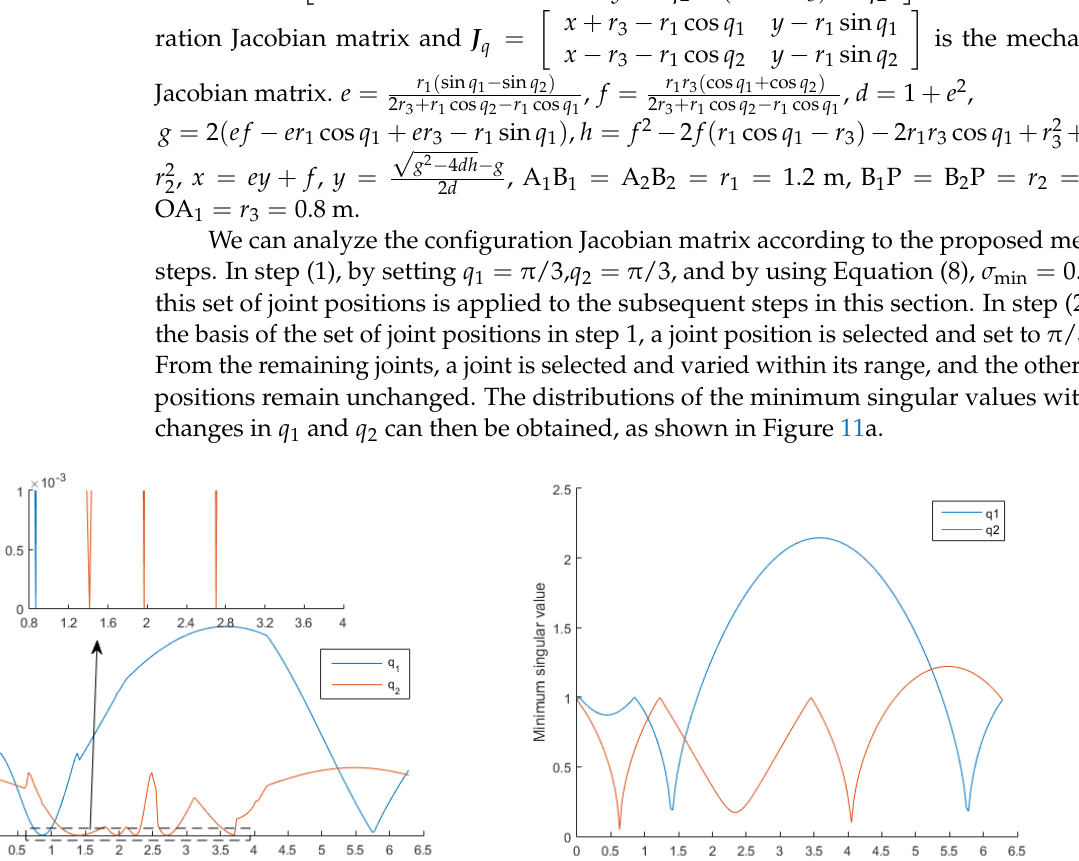
Figure 11. ( a ) The distributions of the minimum singular values of the configuration Jacobian matrix with the changes in q 1 and q 2 ; ( b ) the distributions of the minimum singular values of the mechanism Jacobian matrix with the changes in q 1 and q 2